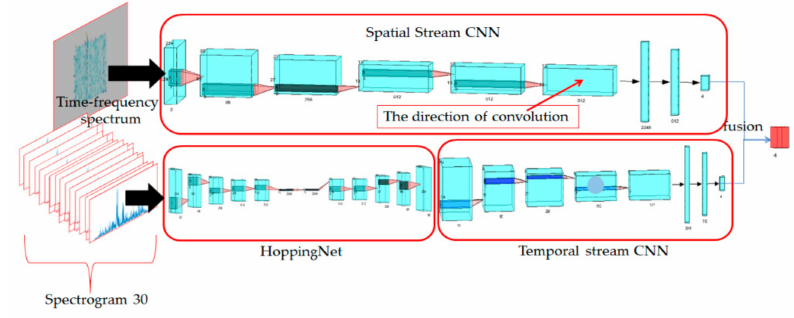
Figure 3. Architecture of our proposed anthropomorphic auditory pattern recognition system. Ventral and dorsal flow parts take the original time-frequency spectrum and time spectrum as input. CNN, convolutional neural